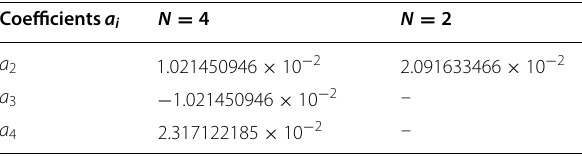
Table 2 Coefficients a i for various N of Rayleigh–Ritz procedure in case